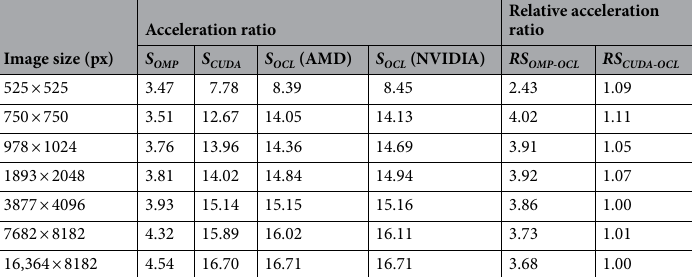
Table 5. Accelerated results comparison.